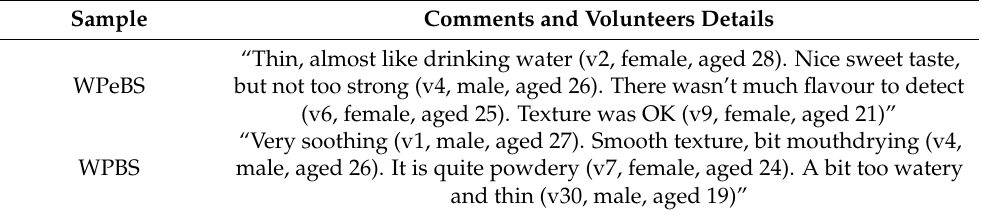
Table 6. Examples of volunteers’ comments relating to whey beverages (WPeBS: whey